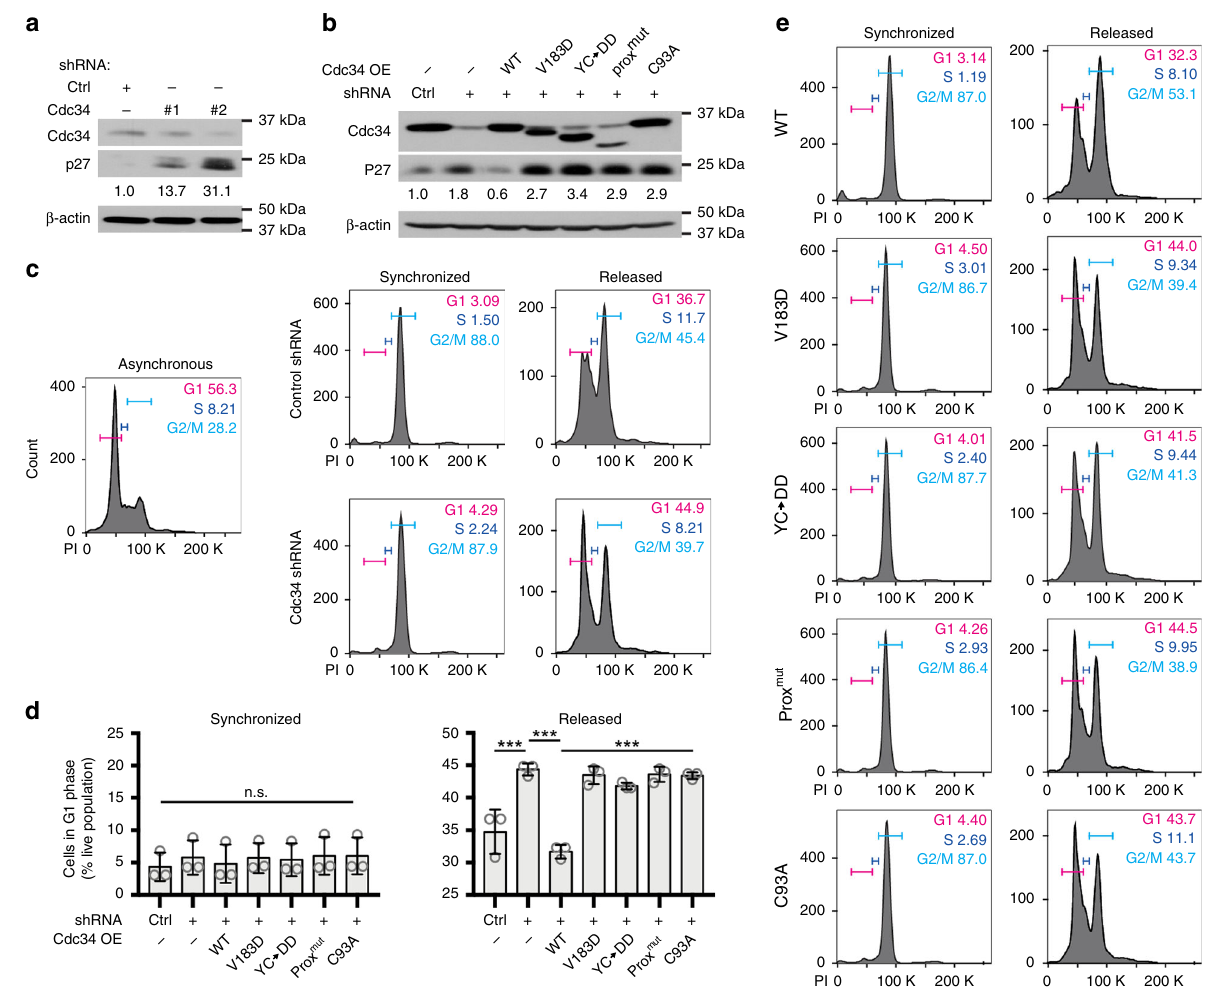
Fig. 7 Cdc34 CTD prox contacts to Ub(t) and the Ubc core are important for Cdc34 function in cells. a , b Representative western blots (for n = 3) of U2OS cells for Cdc34 and p27 after Cdc34 shRNA KD ( a ) and subsequent overexpression of WT or mutant Cdc34 ( b ). c Flow cytometric analysis of U2OS cells treated with control or Cdc34 shRNA then synchronized in G2 phase with nocodazole ( middle ) and released from synchrony for 12 h ( right ) with propidium iodide staining to track DNA content. Left , control asynchronous U2OS cell population subjected to the same analysis. Gates indicate percent of live cell population in stages of cell cycle indicated. d Graphical representation of three independent cell cycle experiments as in c and e with the percent of live cells in G1 phase during G2 synchronization ( left ) and after 12-h release ( right ) represented by the mean ± SD with individual replicates shown as gray circles. Statistical analysis was conducted using a one-way ANOVA with Bonferroni as Post Hoc test ( n = 3), and n.s. indicates non-signi fi cant changes while *** indicates a p- value of < 0.001. e Flow cytometric analysis as in c with Cdc34 shRNA KD followed by WT or mutant Cdc34 overexpression as indicated by labels. Source data for all panels are provided as a Source Data fi